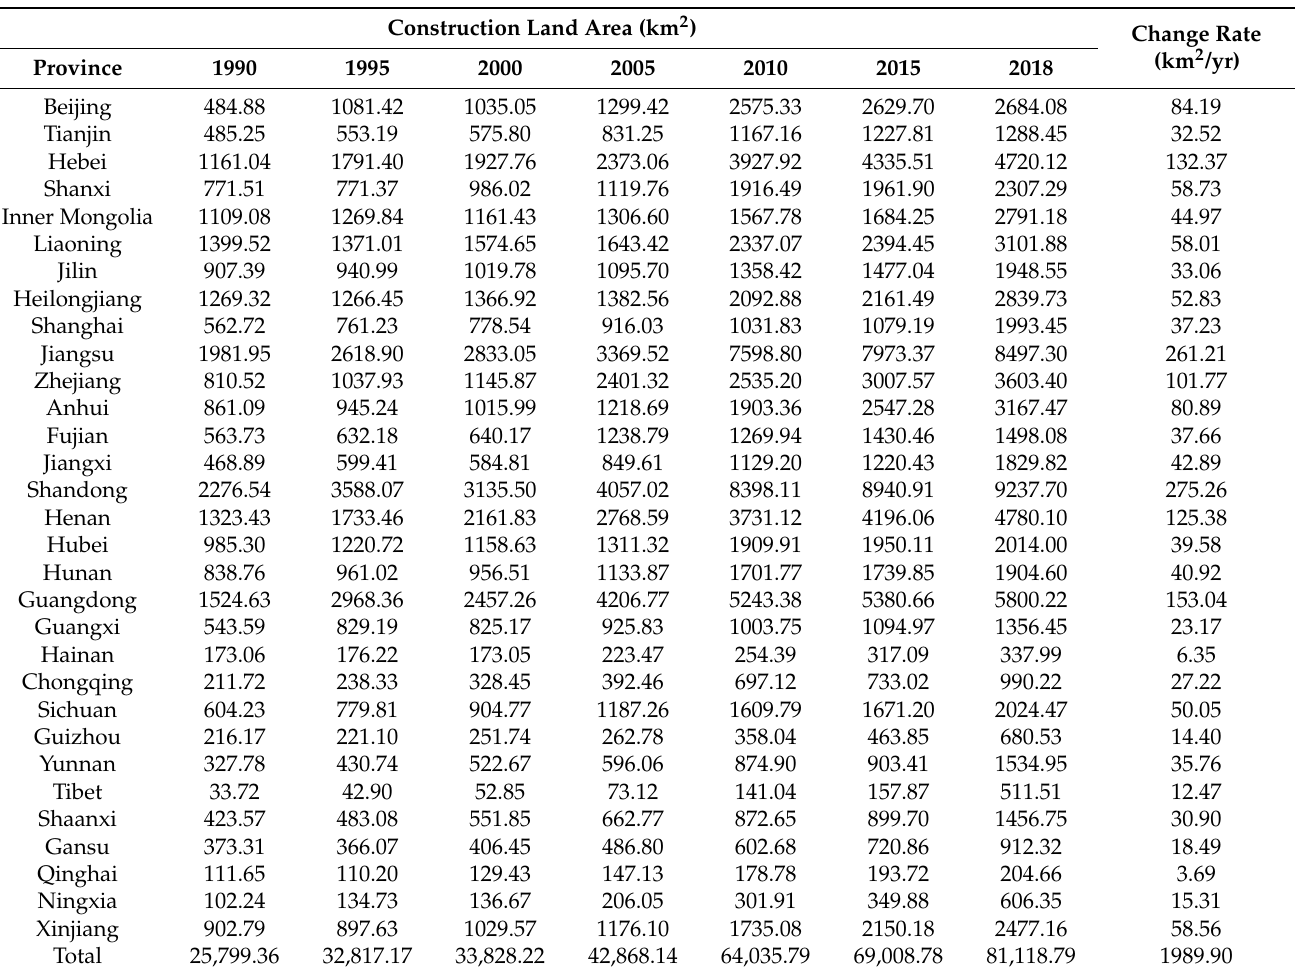
Table 4. The temporal dynamics of construction land in China. Construction Land Area (km 2